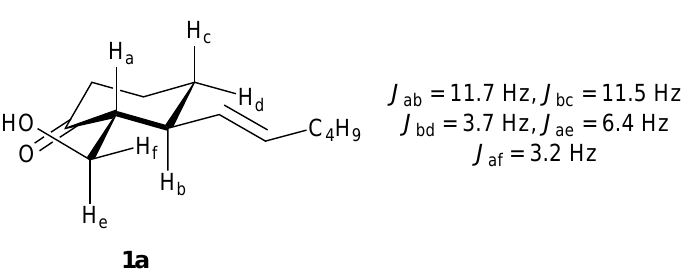
Figure 1. 1 H-NMR structural assignment of 1a .